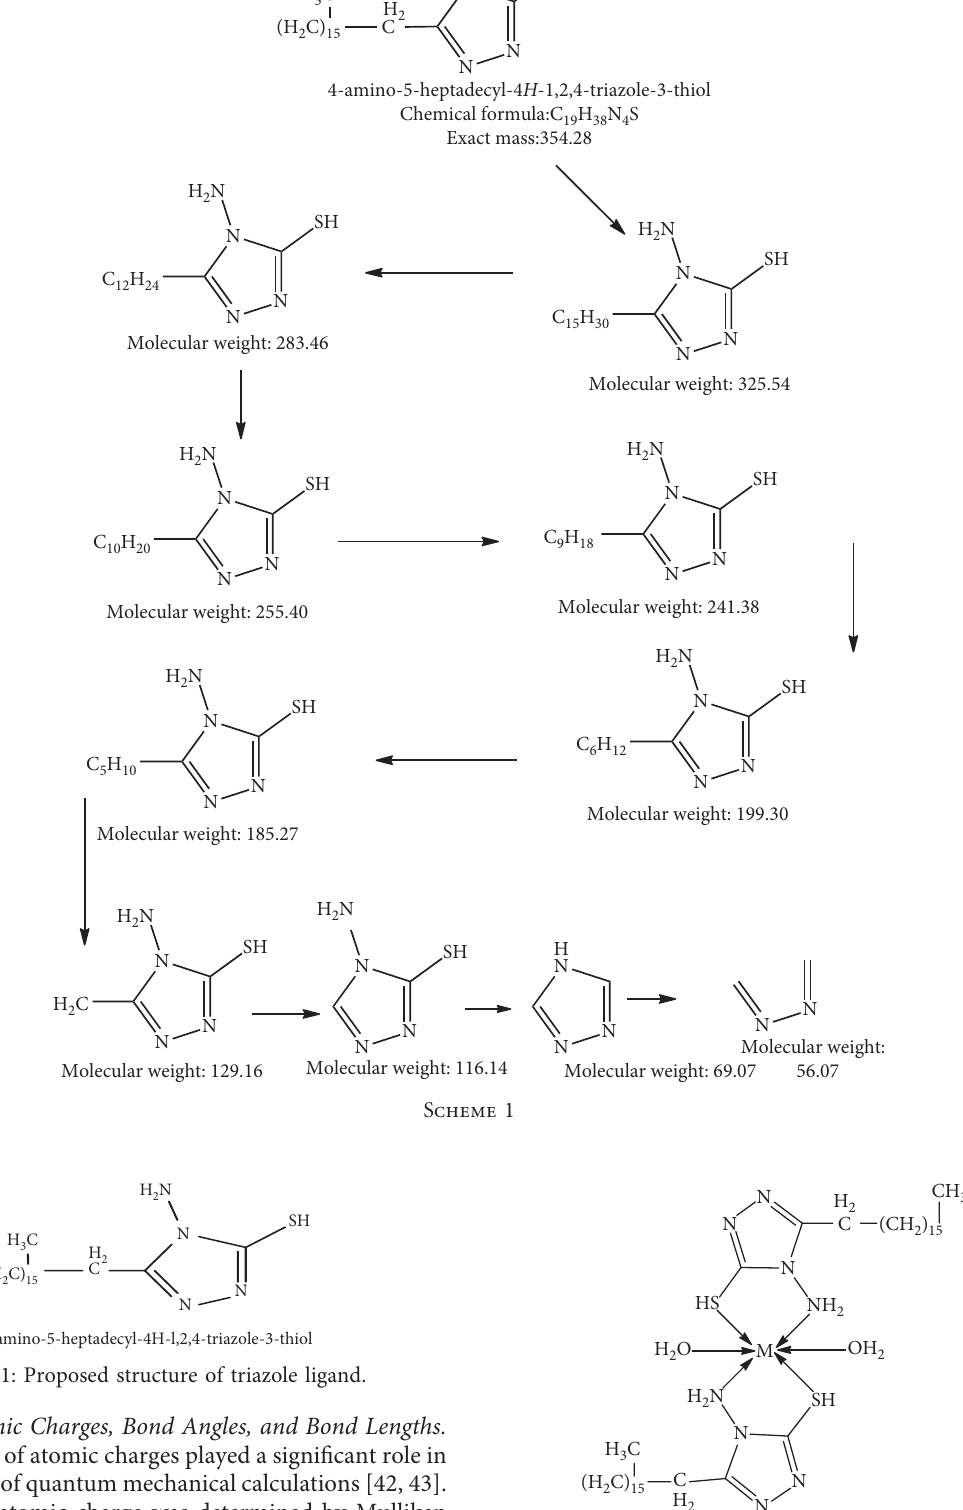
Figure 2: Proposed structure of